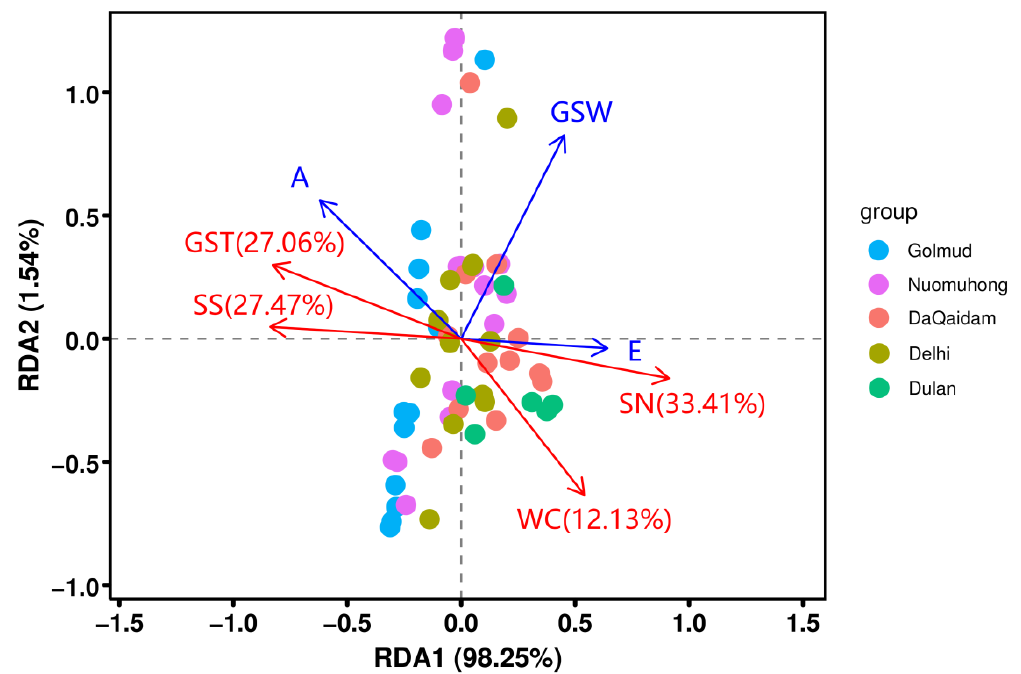
Figure 4. RDA analysis of leaf functional traits and environmental factors.